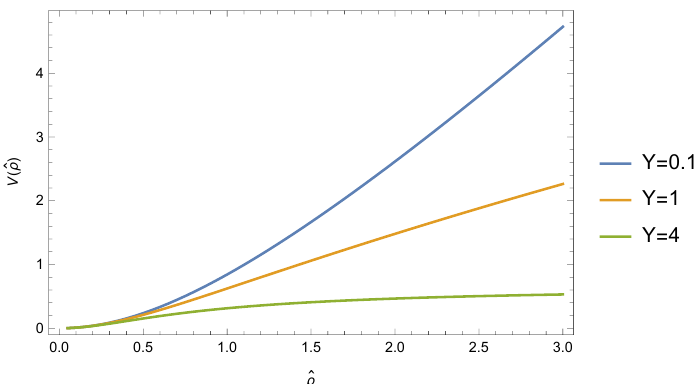
Figure 1 . The single (cid:12)eld scalar potential for the canonically normalised in(cid:13)aton ^ (cid:26) for di(cid:11)erent values of (cid:7) keeping (cid:12)xed ^ G =